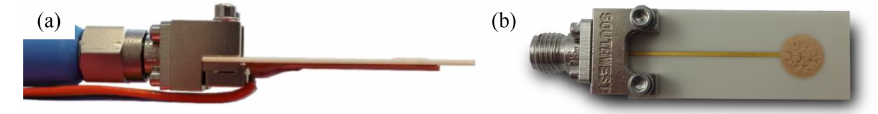
Figure 3. Side (a) and top view (b) of the sensor with the iron zeolite layer above the resonance structure.